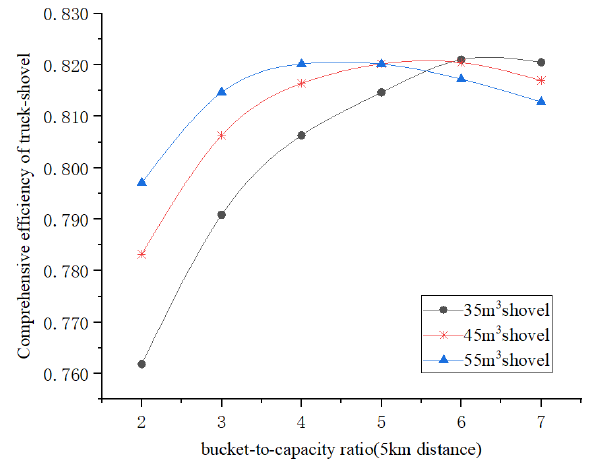
Figure 4. Relationship curves at 5 km transport distance.